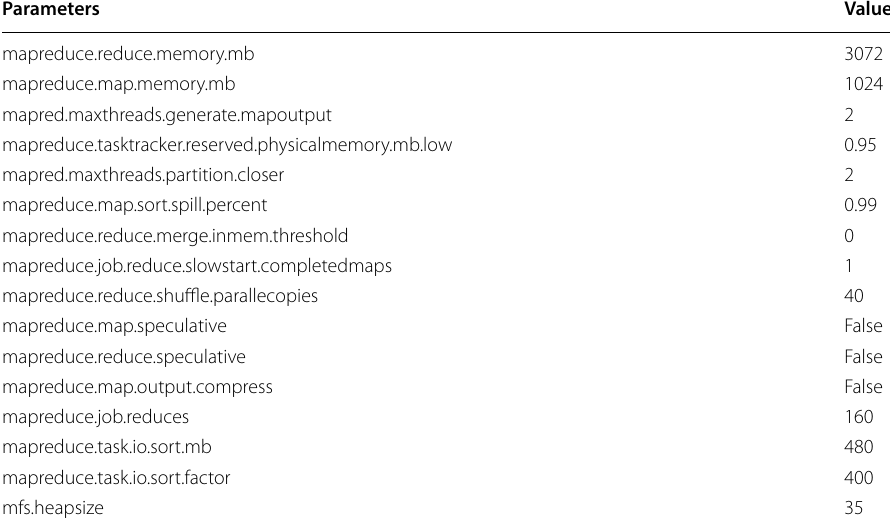
Table 3 The important parameters of the configuration in the experiments Parameters